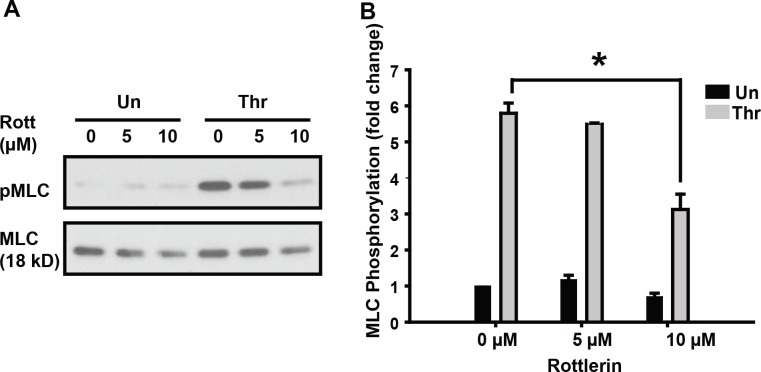
Effect of PKCδ inhibition on thrombin-induced MLC phosphorylation.(A) EC were pretreated with rottlerin (5–10 μM, 30 min) and subsequently stimulated with thrombin (1U/ml, 5 min). Whole cell lysates were immunoblotted with anti-phospho-MLC (Thr18/Ser19) antibody. (B) Relative MLC phosphorylation by densitometry is shown (n ≥ 3/condition, * p < 0.05).